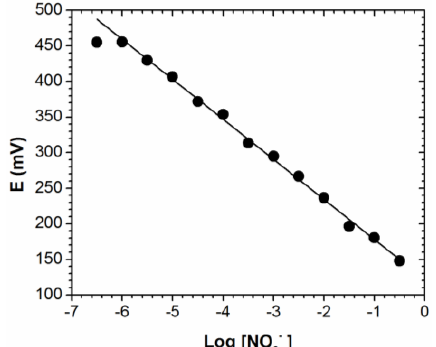
Figure 1. Potentiometric response of an optimized poly( N -methylpyrrole)-based film ion selective electrode (ISE). Data are fitted to a logarithmic curve of equation E = −56.33 log[NO 3− ] + 121.4, R 2 = 0.9974, for data points from [NO 3− ] = 0.5 to 10 −6 M.